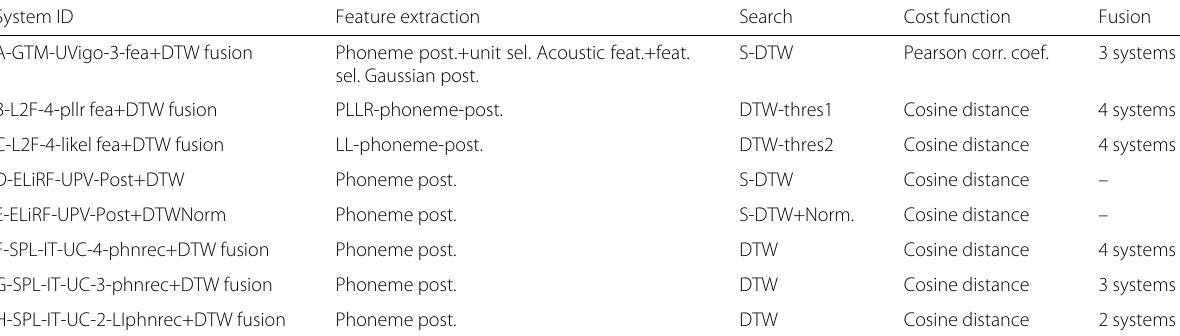
Table 8 Summary of the QbE STD systems System ID Feature extraction